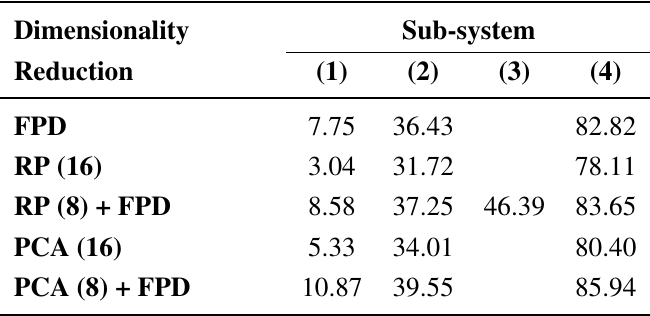
Table 4. Memory footprint (kB) of the sub-systems identified in Figure 6. Tests performed on the IcyFlex WBSN running at 6